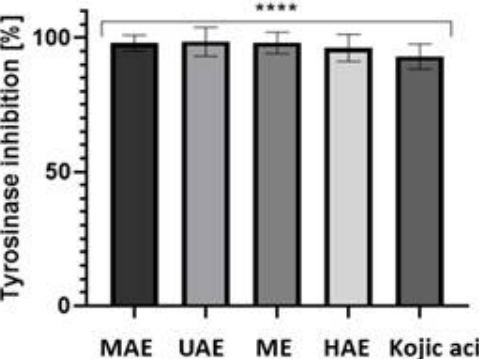
Figure 6. Inhibition of tyrosinase by four types of Schisandra chinensis fruits aqueous extracts (UAE-